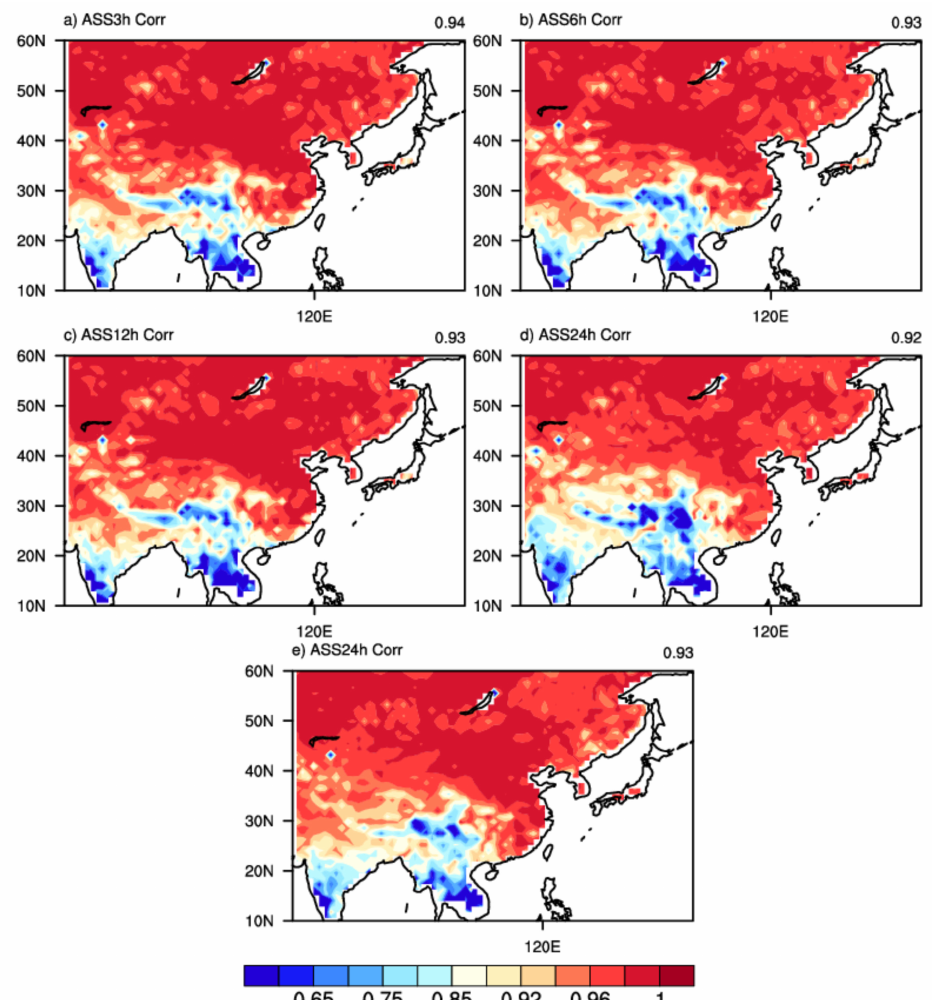
Figure 7. Same as in the Figure 6 but for the nighttime